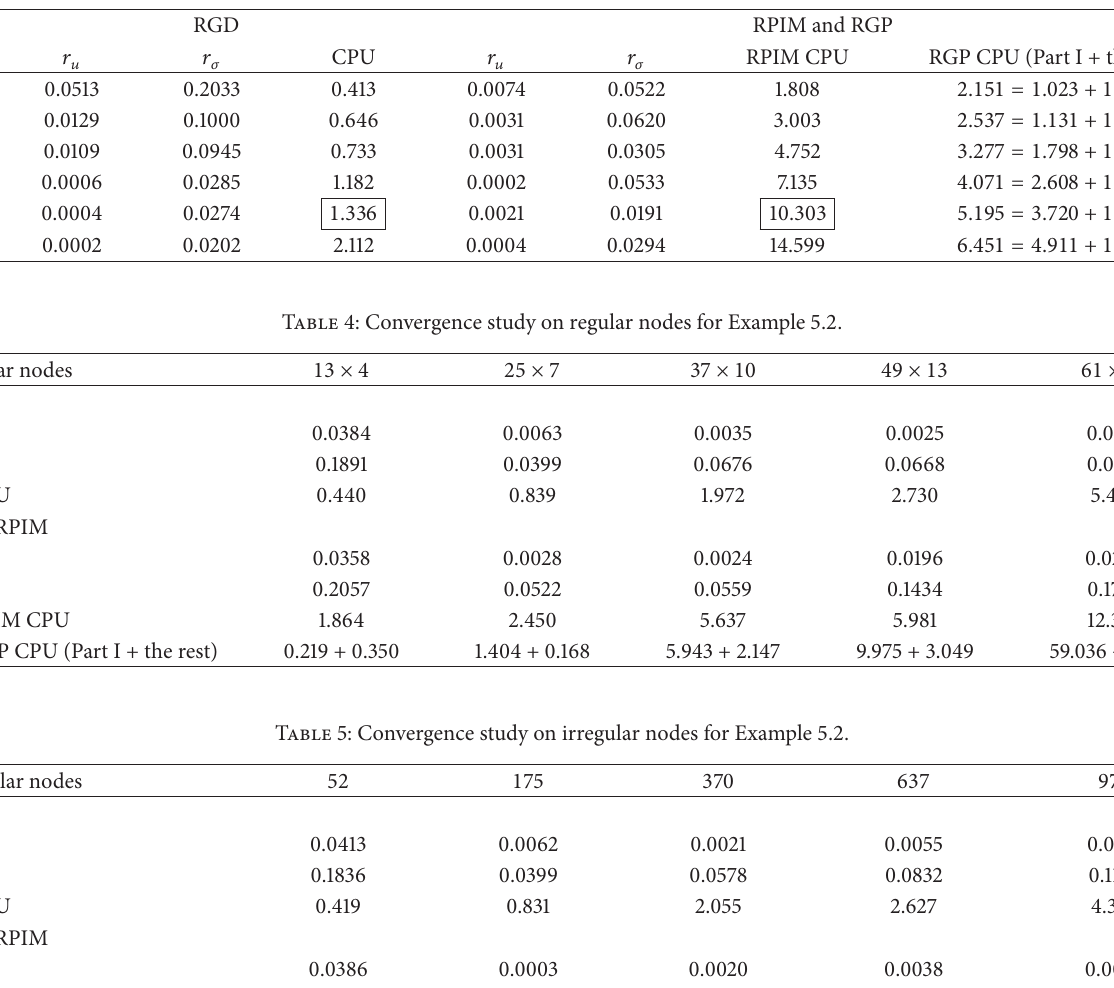
Table 3: Effect of the size of support domain of RGD (Example 5.2 ).